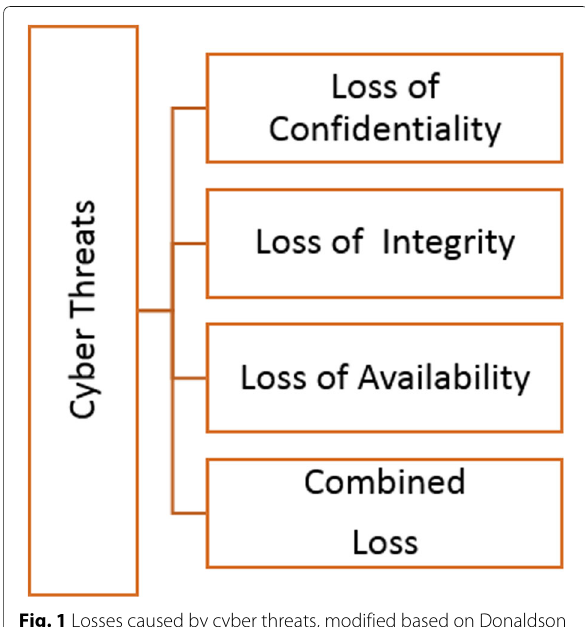
Fig. 1 Losses caused by cyber threats, modified based on Donaldson et al. (2015)